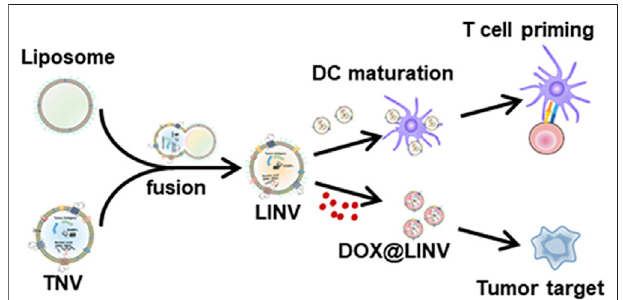
FIGURE 1 | Illustration of the doxorubicin (DOX)-loaded biomimetic hybrid nanovesicles (DOX@LINV) via fusing arti fi cial liposomes (LIPs) with tumor-derived nanovesicles (TNVs) for combinational immunochemotherapy. DOX@LINV with a homologous targeting ability could deliver DOX to tumor tissue and elicit an effective immunogenic cell death response to improve the immunogenicity of a tumor. Meanwhile, the preserved tumor antigens and endogenous danger signals in DOX@LINV activated dendritic cells and induced a subsequent antigen-speci fi c T cell immune response (Hu et al.,